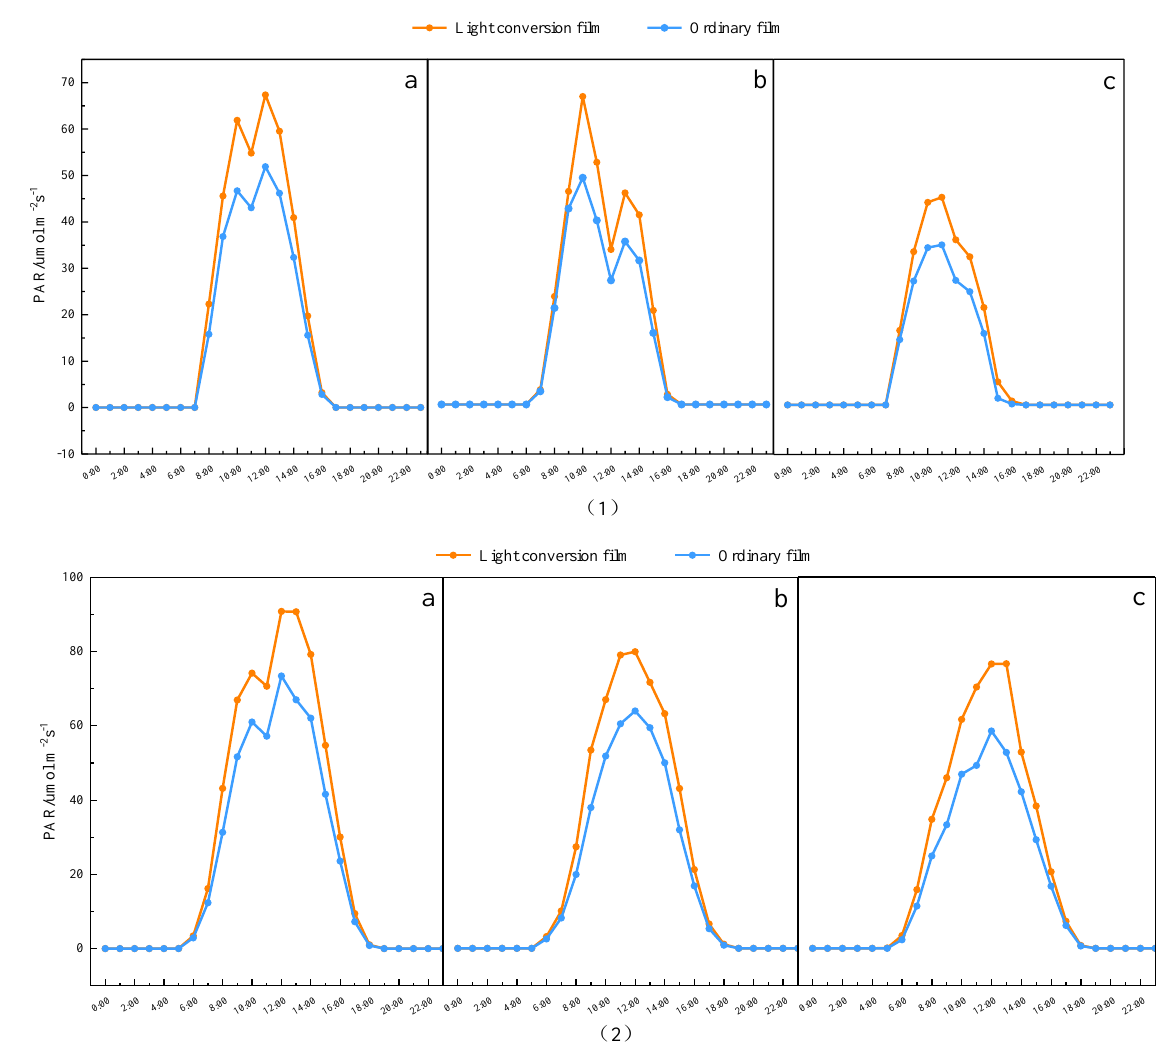
Figure 8. Effect of different crops and different weather on hourly photosynthetic effective radiation of light conversion film (LCF) and ordinary film (OF). ( 1 ) indicates the impact of LCF and OF on PAR in the first crop, and ( 2 ) indicates the impact of LCF and OF on PAR in the second crop (( a ) indicates sunny weather; ( b ) indicates cloudy weather; ( c ) indicates haze weather).